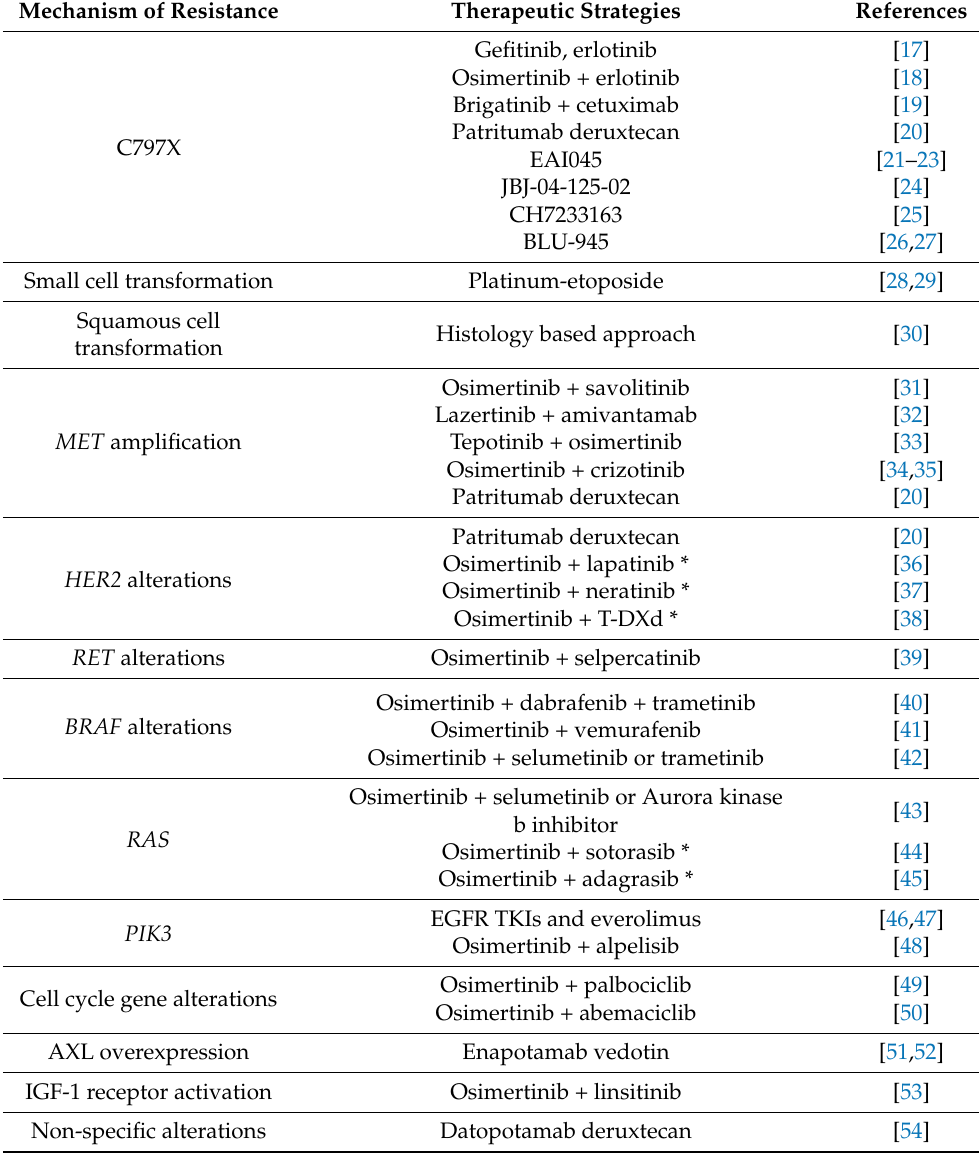
Table 1. Mechanism of resistance to osimertinib and proposed therapeutic options.